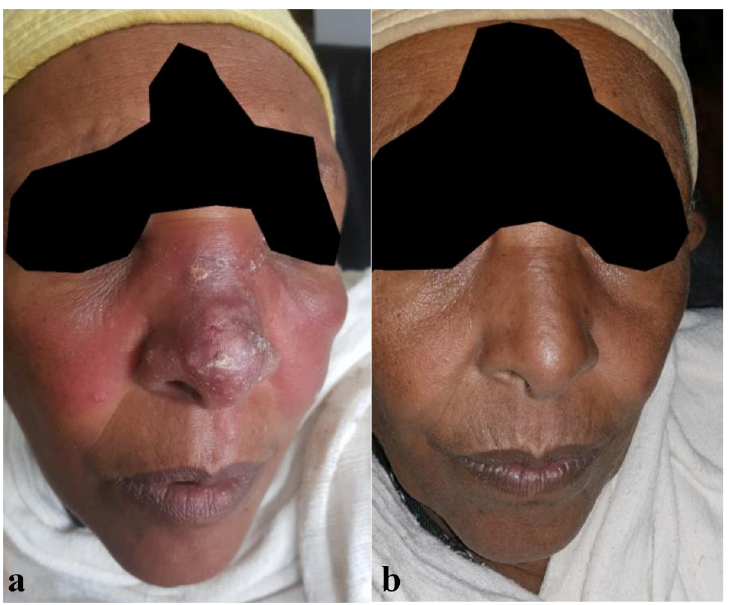
Fig 2. Patient with large lesion of 12 months duration classified as DCL on the nose and cheeks with features of erythema, swelling, and crusted plaques on the nose. (A) Lesion before treatment. (B) The lesion healed without residual scar at day 180.